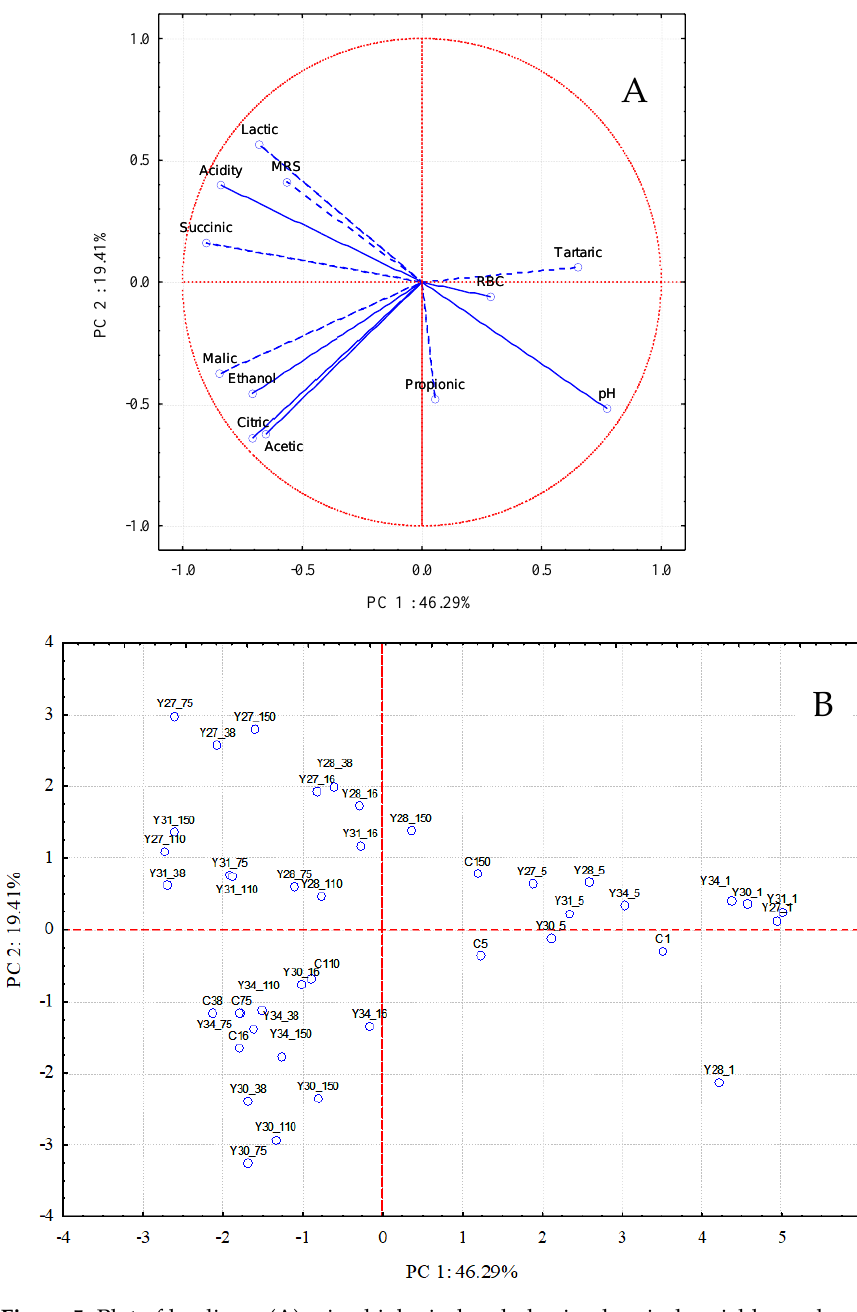
Figure 5. Plot of loadings: ( A ) microbiological and physicochemical variables and scores; ( B ) sam- pling days of the different fermentation processes in the plane of the first two principal components (C: spontaneous fermentation; Y27, Y28, Y30, and Y31: inoculated fermentations with different strains of C. boidinii ; Y34: inoculated fermentation with S. cerevisiae ; sampling time: 1, 5, 16, 38, 75, 110, and 150 days).